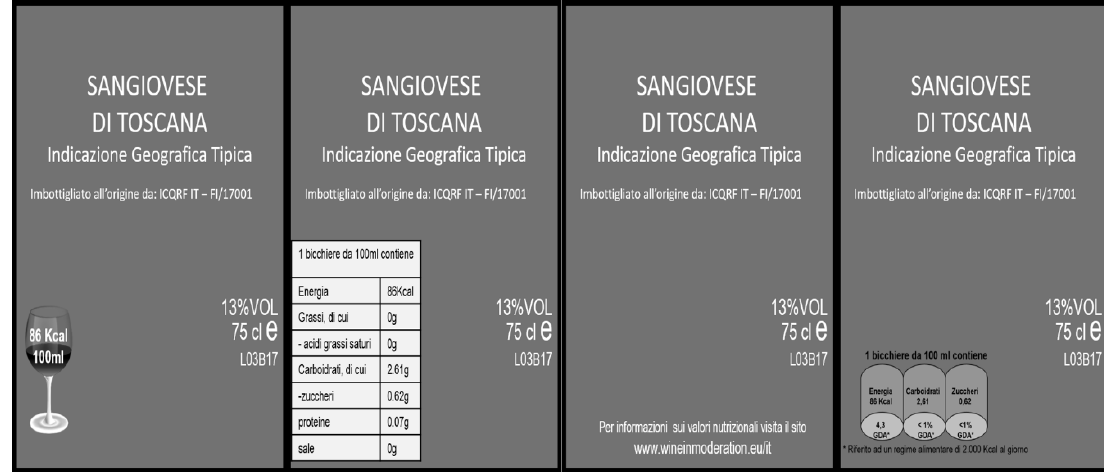
Figure 1 . Stimuli applied in the AFE. Figure 1. Stimuli applied in the